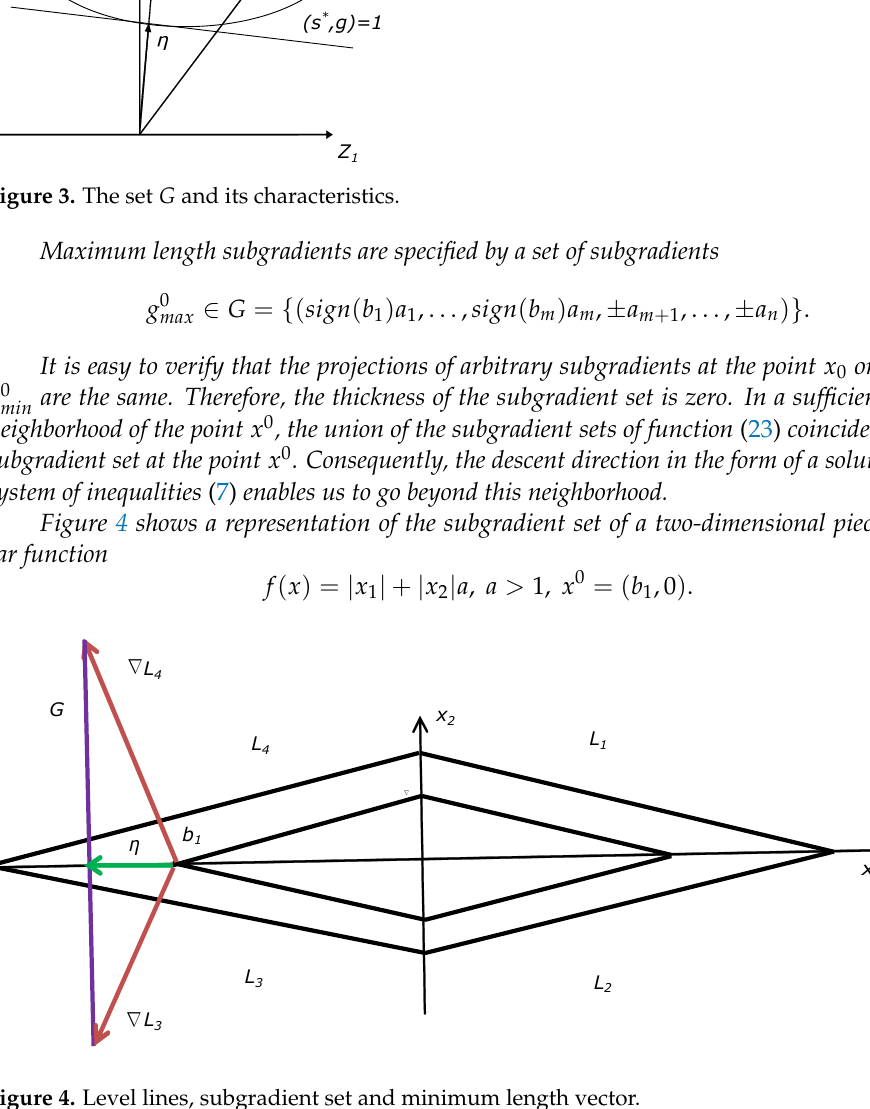
Figure 4. Level lines, subgradient set and minimum length